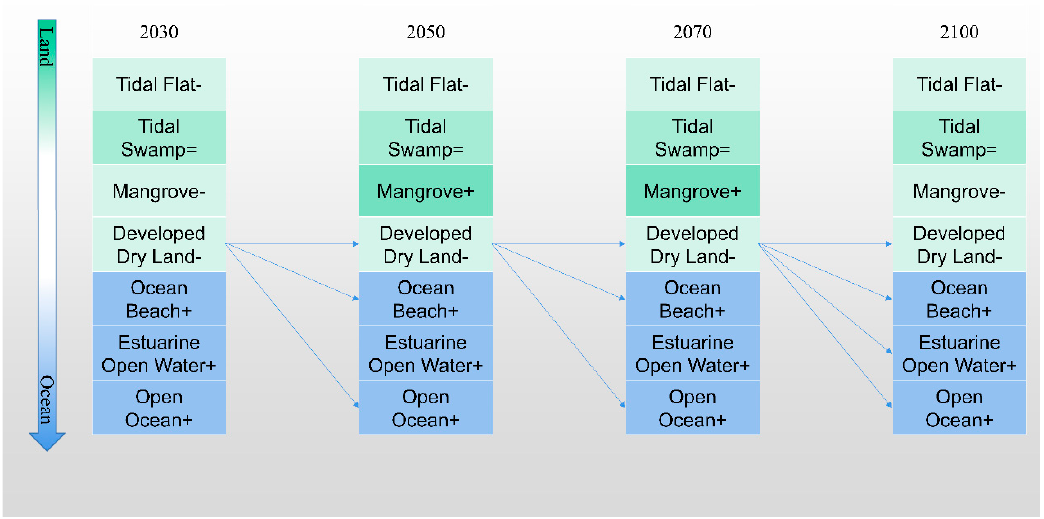
Figure 7. Land use transfers highlighting developed dry land: Guangxi in